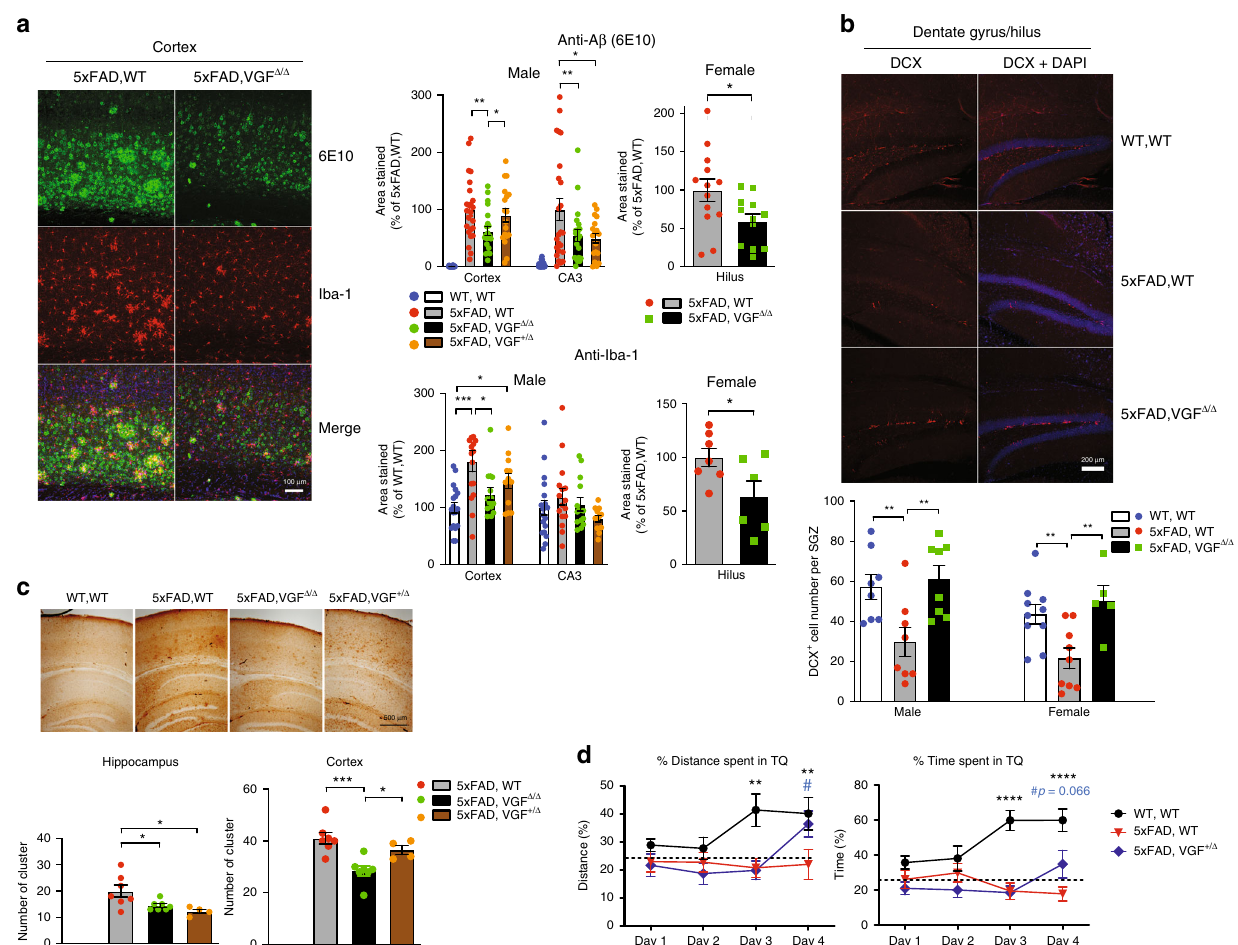
Fig. 5 Characterization of AD pathophysiology in wild-type, 5xFAD, and 5xFAD mice overexpressing VGF. a Immunohistochemical staining of A β amyloid plaques and microglial cells in the male mouse cortex of 5xFAD mice overexpressing VGF in the germline. Left panel, green: A β (6E10), red: Iba-1, blue: DAPI; right panel, quanti fi cation of percent area of A β and Iba-1 staining in male and female mice. Quanti fi cation of percent area of A β and Iba-1 staining in the cerebral cortex, hippocampal CA3, and hilus; data are presented as mean percentage± SEM of the control group. One-way ANOVA with Newman – Keuls post hoc analysis, cortex (anti-A β ): F (3,86) = 30.84, p < 0.0001, CA3 (anti-A β ): F (3,86) = 12.44, p < 0.0001, cortex (anti-Iba-1): F (3,56) = 7.307, p = 0.0003, n = 9, 8, 7, 6 mice per group, 2 – 3 slices analyzed per animal, * p < 0.05, ** p < 0.01, *** p < 0.001; female: n = 7, 6 mice per group, two- sided Student ’ s t test, p = 0.031 (A β ), p = 0.0454 (Iba-1). b Doublecortin staining (DCX) of the subgranular zone (SGZ) in the dentate/hilus area of male 5xFAD brains. Upper panel, red: DCX, blue: DAPI; lower panel, average number of DCX-positive cells per subgranular zone. One-way ANOVA with Newman – Keuls post hoc analysis, male: F (2, 21) = 6.652, p = 0.0058, n = 4, 4, 4 mice per group, 2 slices analyzed per animal; female: F (2, 21) = 7.008, p = 0.0047, n = 10, 9, 5 mice per group. ** p < 0.01 c Reduced staining of phosphor-Tau and dystrophic neurite clusters in 5xFAD brains with germline VGF overexpression. Upper panel: phosphor-Tau staining; lower panel: quanti fi cation results of dystrophic neurite clusters in the hippocampus and cortical area. One-way ANOVA with Newman – Keuls post hoc analysis, cortex: F (2, 15) = 10.92, p = 0.0012, hippocampus: F (2, 15) = 5.549, p = 0.0157, n = 7, 7, 4 male mice/per group. * p < 0.05, *** p < 0.001. d Barnes maze test. Mice were trained daily and WT mice learned the target quarter (TQ) of the hiding zone by increased distance traveled in the TQ (left panel) and increased time spent in the TQ (right panel). 5xFAD mice showed impaired spatial learning on day 4, while germline VGF overexpression (5xFAD,VGF + / Δ ) partially restored memory performance. N = 12 – 14 mice (male + female) per group. Data were analyzed by two-way repeated-measures ANOVA. % of distance spent in TQ: Days (F (3,108) = 3.215, p < 0.05) and Groups ( F (2,36) = 8.77, p < 0.001), and Days × Groups interaction ( F (6,108) = 1.9, p = 0.0873). % time spent in TQ: Days ( F (3,105) = 2.422, p = 0.07) and Groups ( F (2,35) = 20.01, p < 0.0001), and Days × Groups interaction ( F (6,105) = 4.501, p < 0.001). Tukey ’ s post hoc test. # p < 0.05, ** p < 0.01, **** p < 0.0001. All data in b – d are presented as mean percentage±